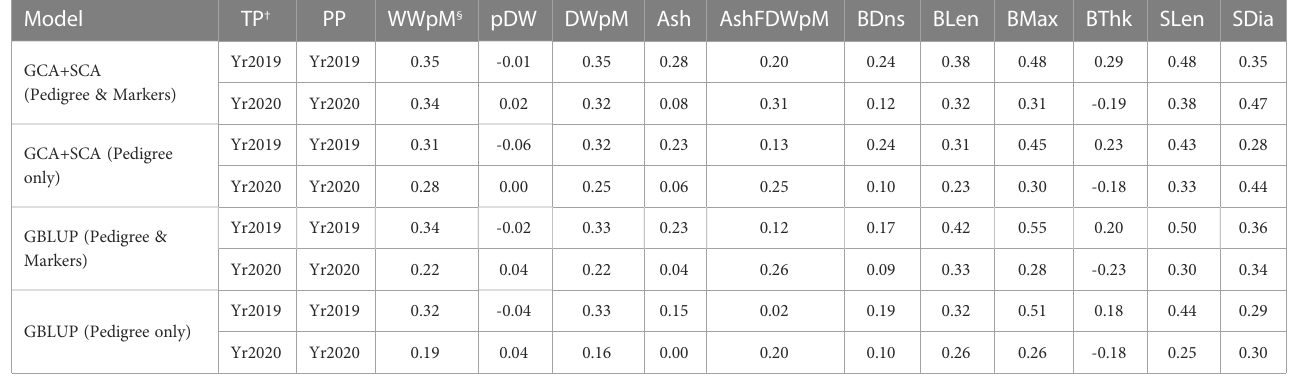
† TP: Training Population; PP: Prediction Population. § For trait abbreviations refer to Table